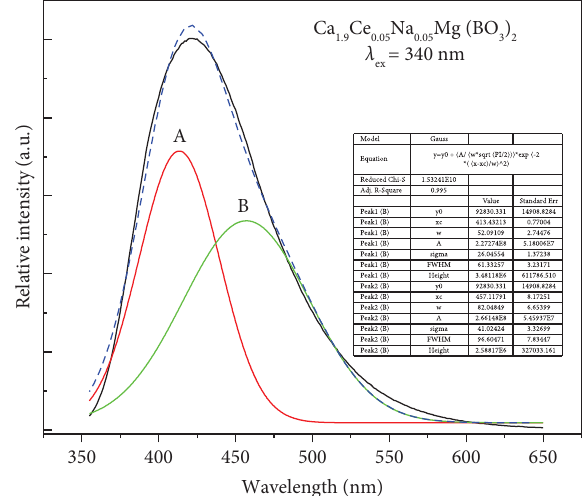
Figure 1: XRD patterns of Ca 0.03, 0.05, 0.07, and 0.09).